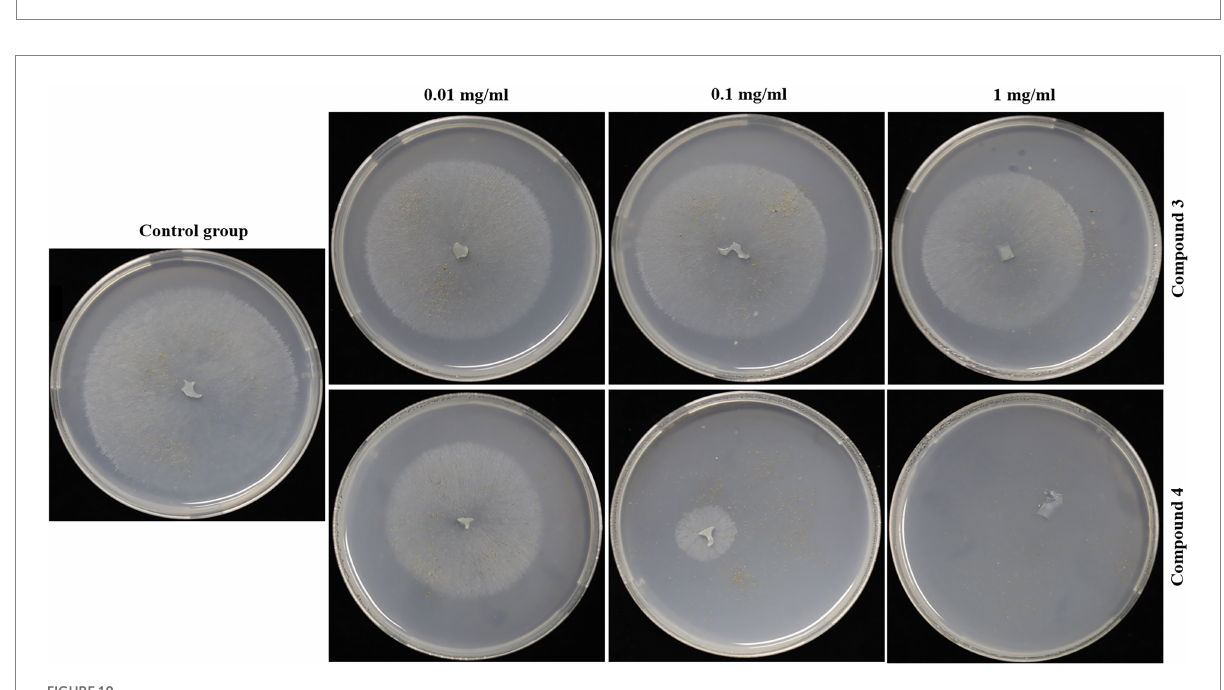
FIGURE 10 Inhibitory effects of 3 and 4 on GS2.